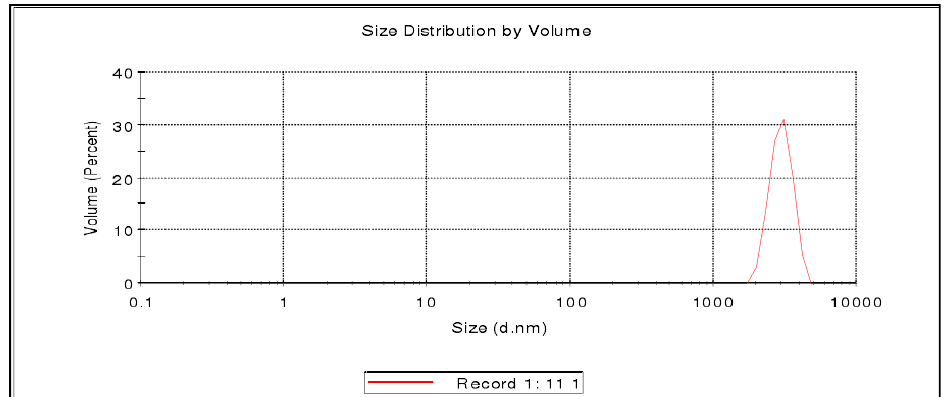
Figure 3. The size distribution of PPM. Table 1. The drug content and encapsulation efficiency of PPM.